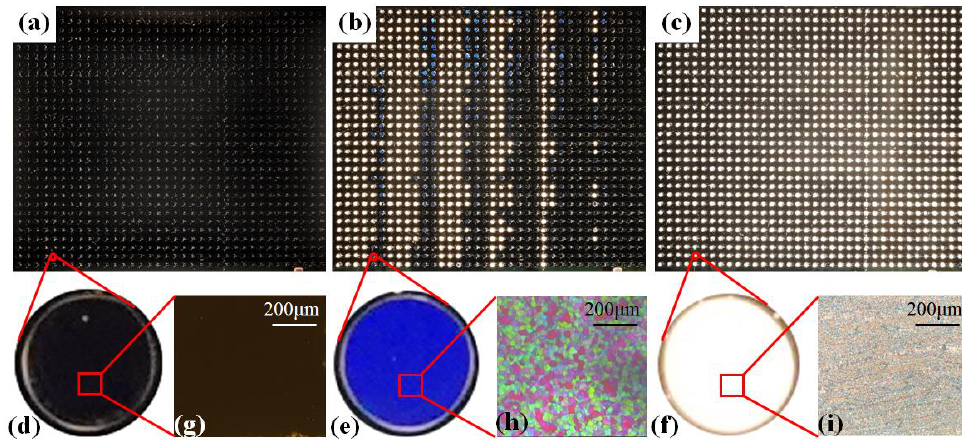
Figure 3. ( a – c ) Images of 1080 sample points at the initial (80 °C), middle (39 °C) and final stages (7 °C) of acquisition. ( d – f ) The images of sample points in isotropic phase, blue phase and cholesteric phase, respectively, and ( g – i ) the corresponding polarizing microscope photos.